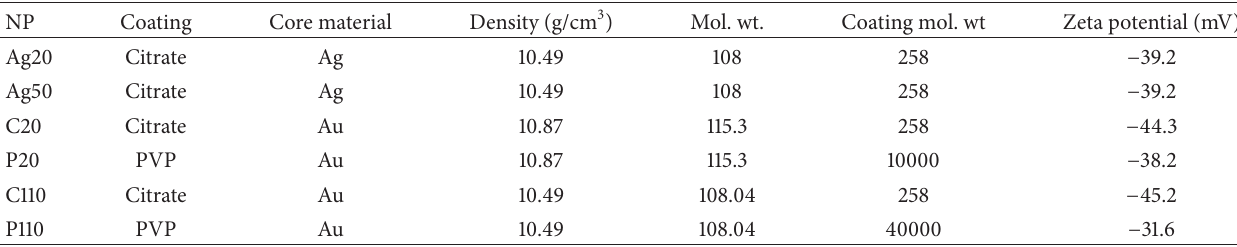
Table 1: Properties of silver NPs used in the